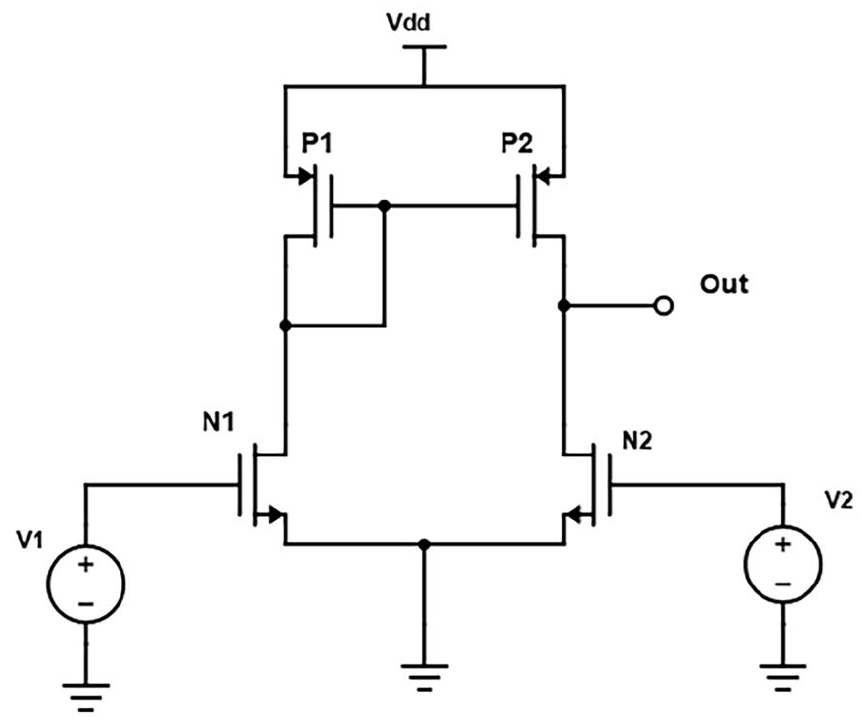
Figure 4. Differential Sense Amplifier Schematic.